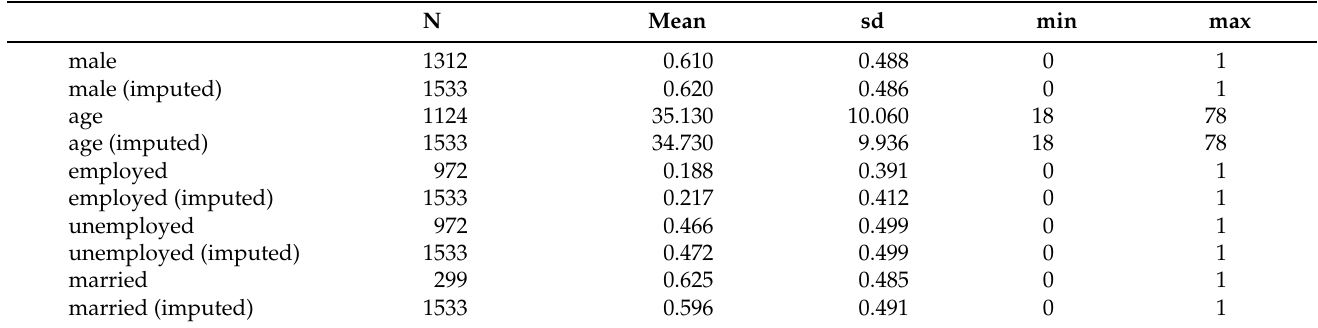
Table A4. Descriptive statistics of imputed vs. non-imputed demographics. Source: Own